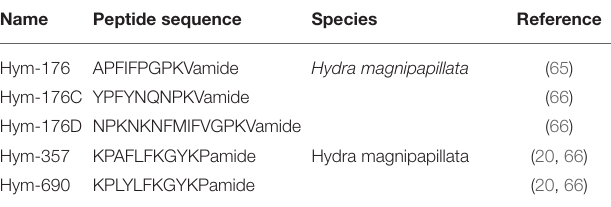
TABLE 3 | Hym-176, Hym-357, and their related peptides in